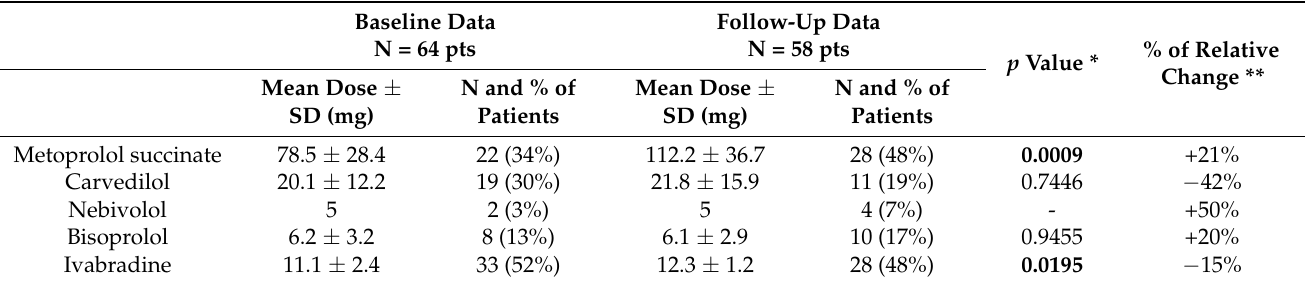
Figure 5. Graphical representation of drug management—number of interventions in medication/year. Table 4. Drug management analysis: baseline data versus follow-up